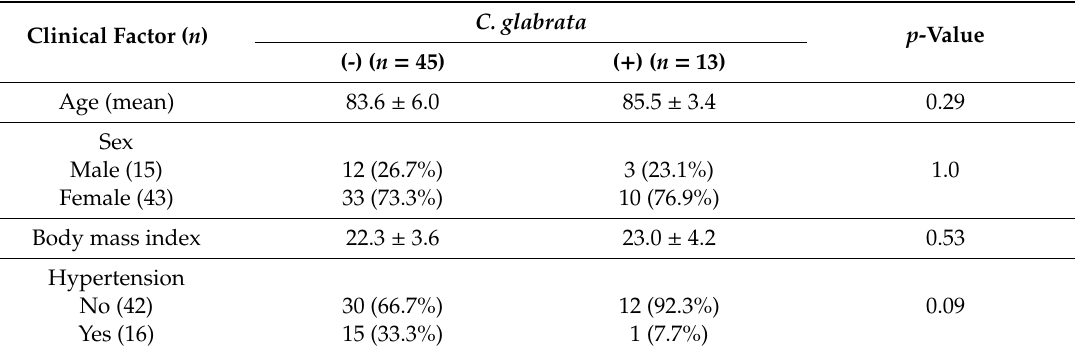
Table 6. Correlation between C. glabrata detection and clinical factors among independent and dependent older